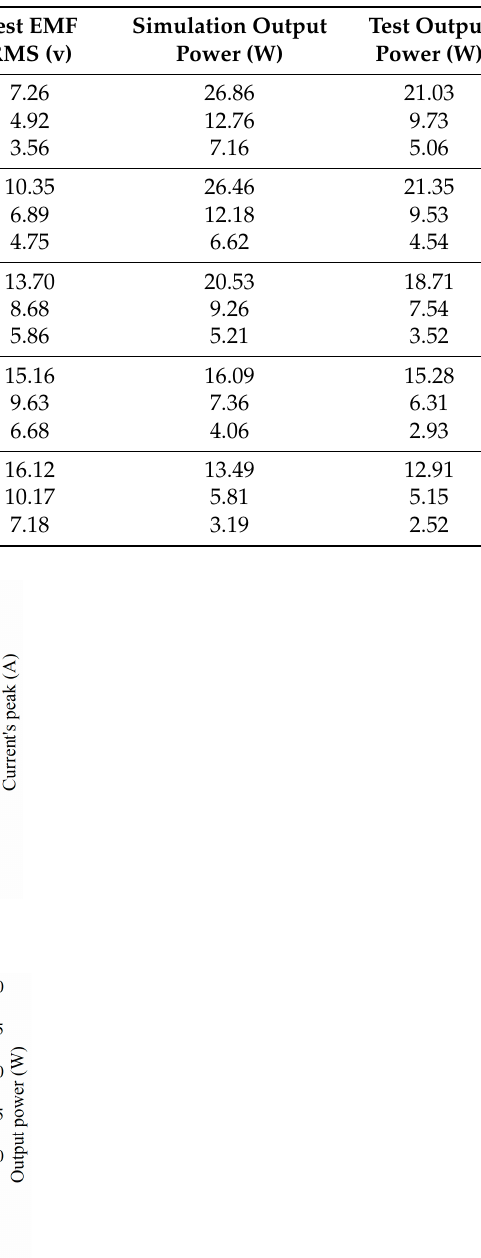
Table 5. The output characteristics of PMLG under different frequency and loads.